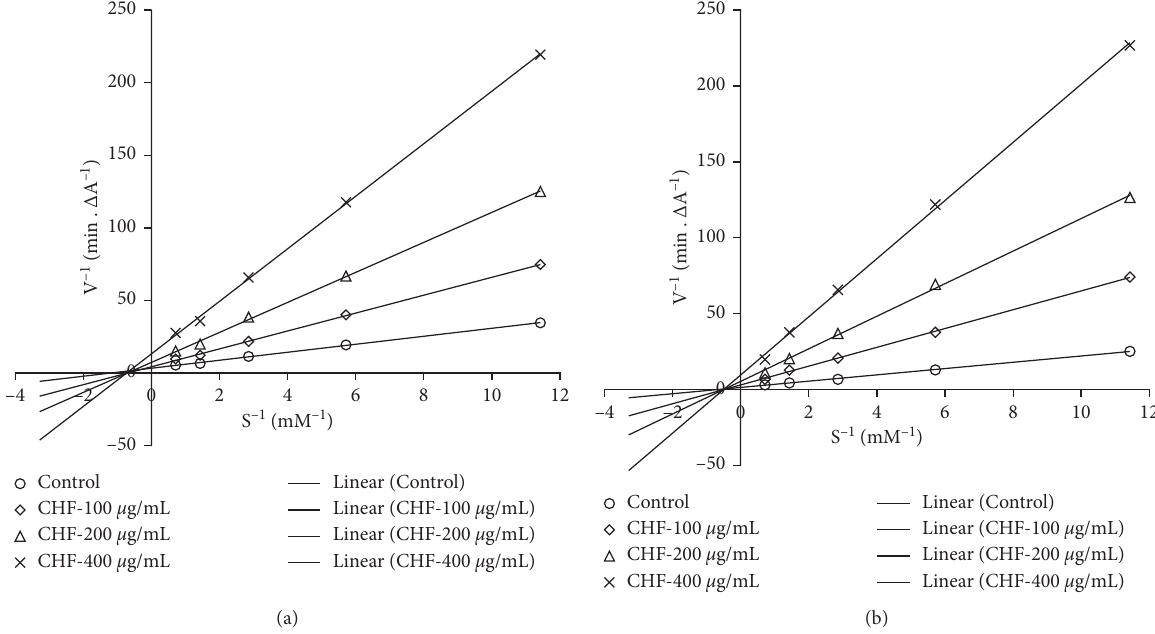
Figure 3: Lineweaver–Burk plot for inhibition of AChE (a) and BuChE (b) by different concentrations of CHF. Results represent the average values ( n �